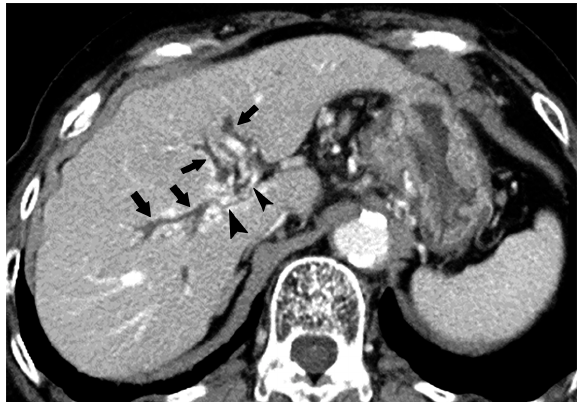
Figure 17. Intrahepatic portal vein thrombosis in an 84-year-old woman. In the portal venous